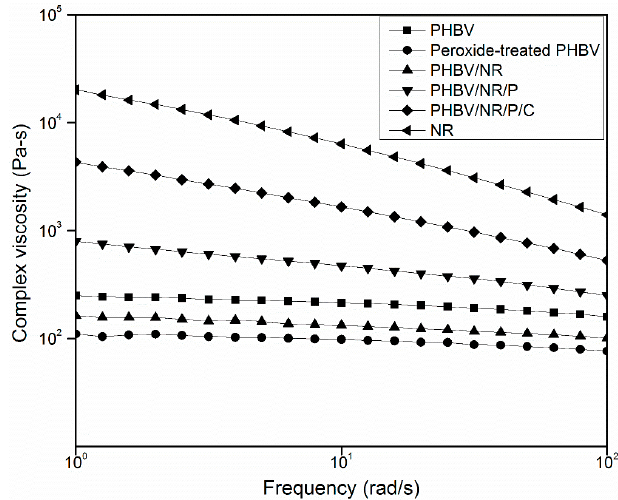
Figure 2. Complex viscosities of pristine PHBV, pristine NR, and PHBV/NR blends at 175 °C.